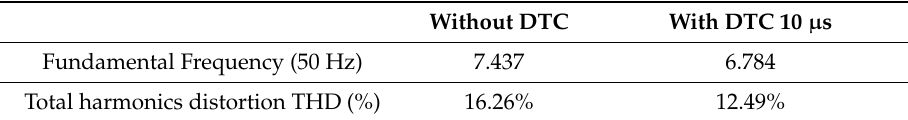
Table 4. FFT analysis of the load